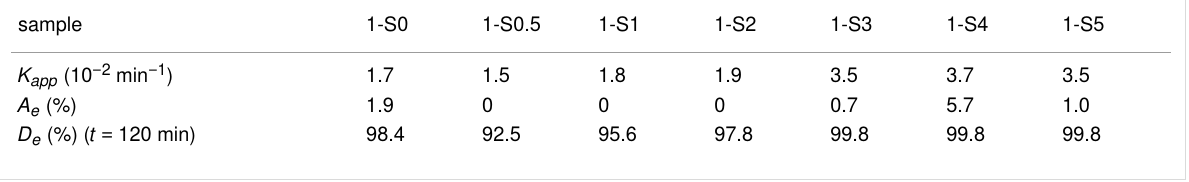
Table 4: The values of the adsorption efficiency ( A e ), degradation efficiency ( D e ) and the apparent reaction rate constant K app for the samples pre- pared at 180 °C. sample